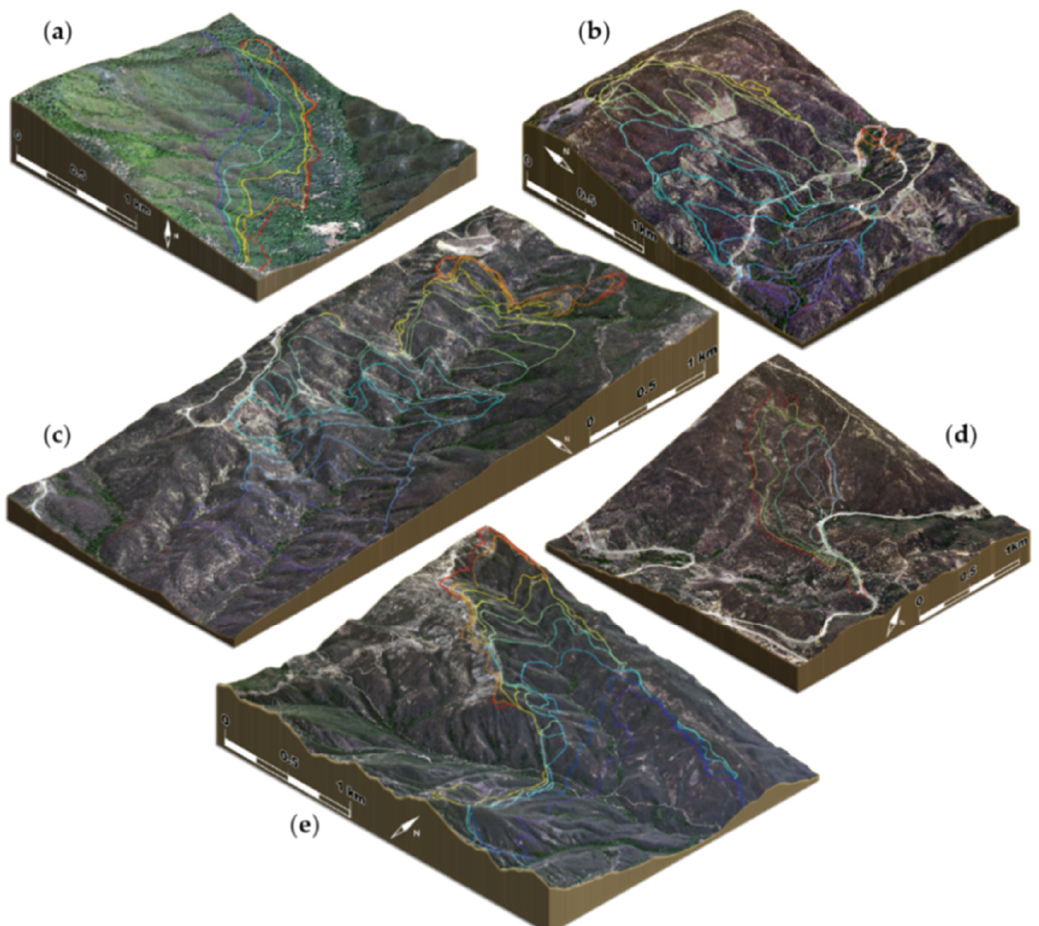
Figure 3. Airborne thermal infrared fire spread sequences overlaid on 3D terrain models. Progression of color spectrum depicts movement of fire fronts over time. ( a ) Detwiler; ( b ) Thomas 1; ( c ) Thomas 2; ( d ) Thomas 3; ( e ) Thomas 4. The average times between successive fire front positions (min) are 8:07 (Detwiler), 10:09 (Thomas 1), 8:24 (Thomas 2), 7:05 (Thomas 3), and 6:08 (Thomas 4).